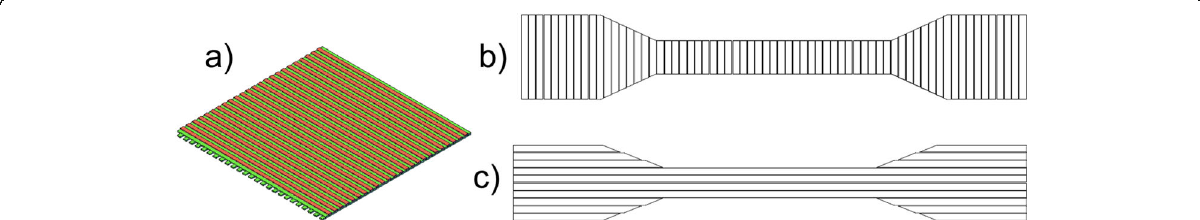
Fig. 1 a CAD-model of the PLA-based hygromorph consisting of mutually perpendicular passive layers (green) and an active layer (red). The length and width is 5 cm. b and c Schematic illustration of the axial and radial tensile bars with the corresponing print paths for the determination of the elastic